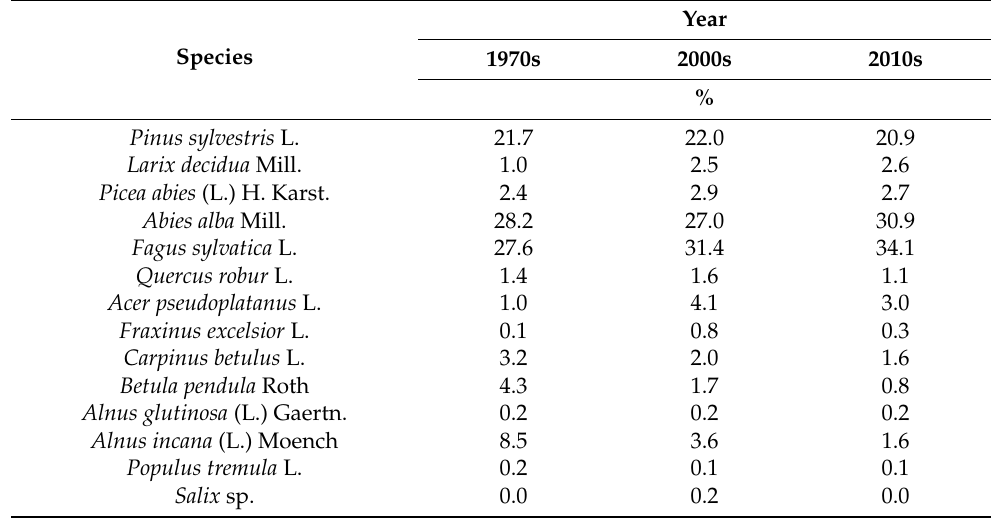
Table 1. Percentages of dominant tree species in forest stands during the 1970s, 2000s and 2010s. Data are from Forest Management Plans. The table includes species whose percentage share was greater than 0.1.